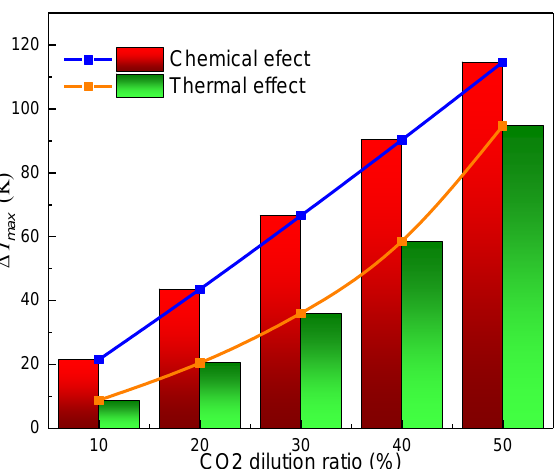
Figure 4. The comparison of the chemical effect and thermal effect on the flame temperature at p = 1 atm, 𝛼 𝑠 = 10 s −1 , β = 0–50%.